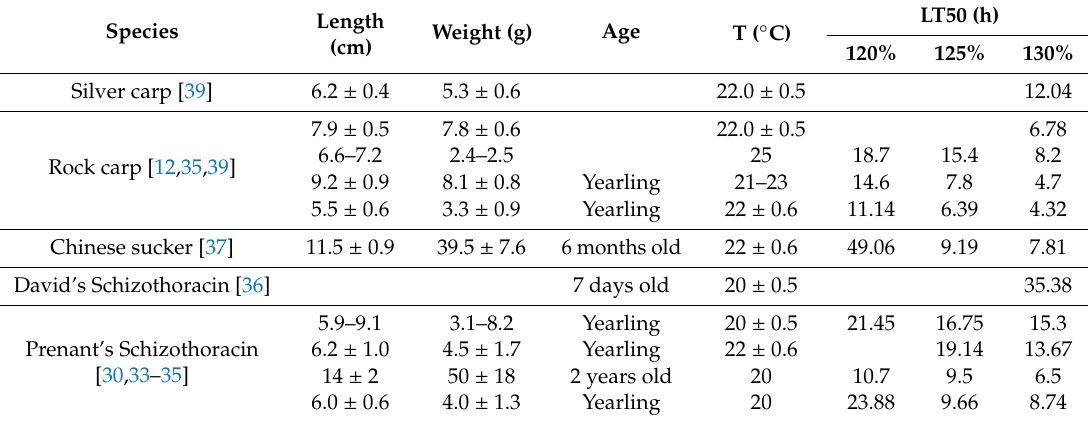
Table 5. Previous studies on the tolerance of fish in the Yangtze River to TDG supersaturation. Some data are not given in the table because they were not provided in previous